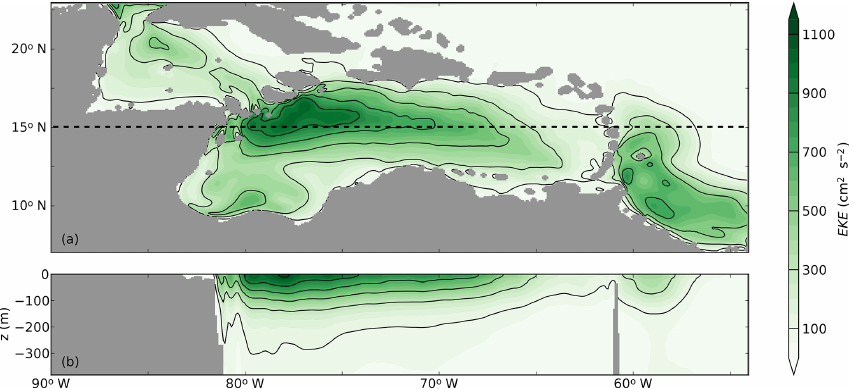
Figure 4. Eddy kinetic energy (EKE; cm 2 s − 2 ) of Ekman100 obtained from 5d averaged velocity fields that are high-passed filtered with a 125d mean. (a) The 20-year average of the EKE in the upper 50m of the water column and (b) a cross section of EKE at 15 ◦ N over the upper